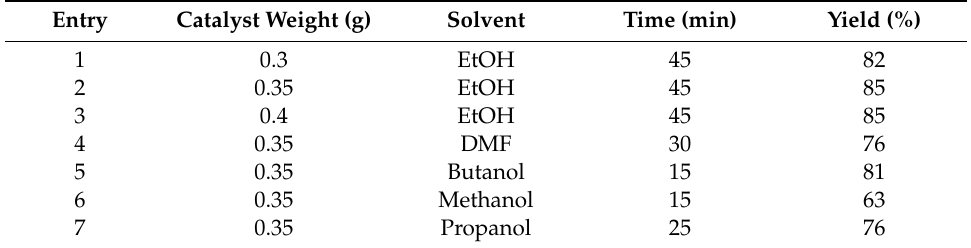
Table 3. Optimization of reaction condition for synthesis of 3 utilizing CoMgAl-LDH catalyst under ultrasonic